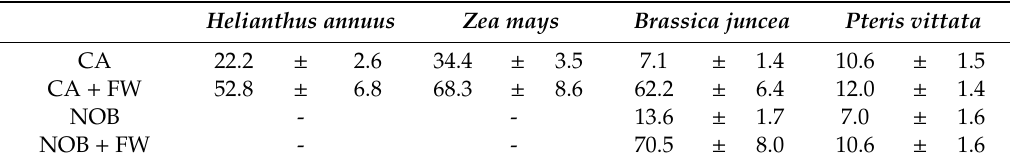
Table 4. Total fresh weight (aerial parts + roots) (g / plant) ± SD of the